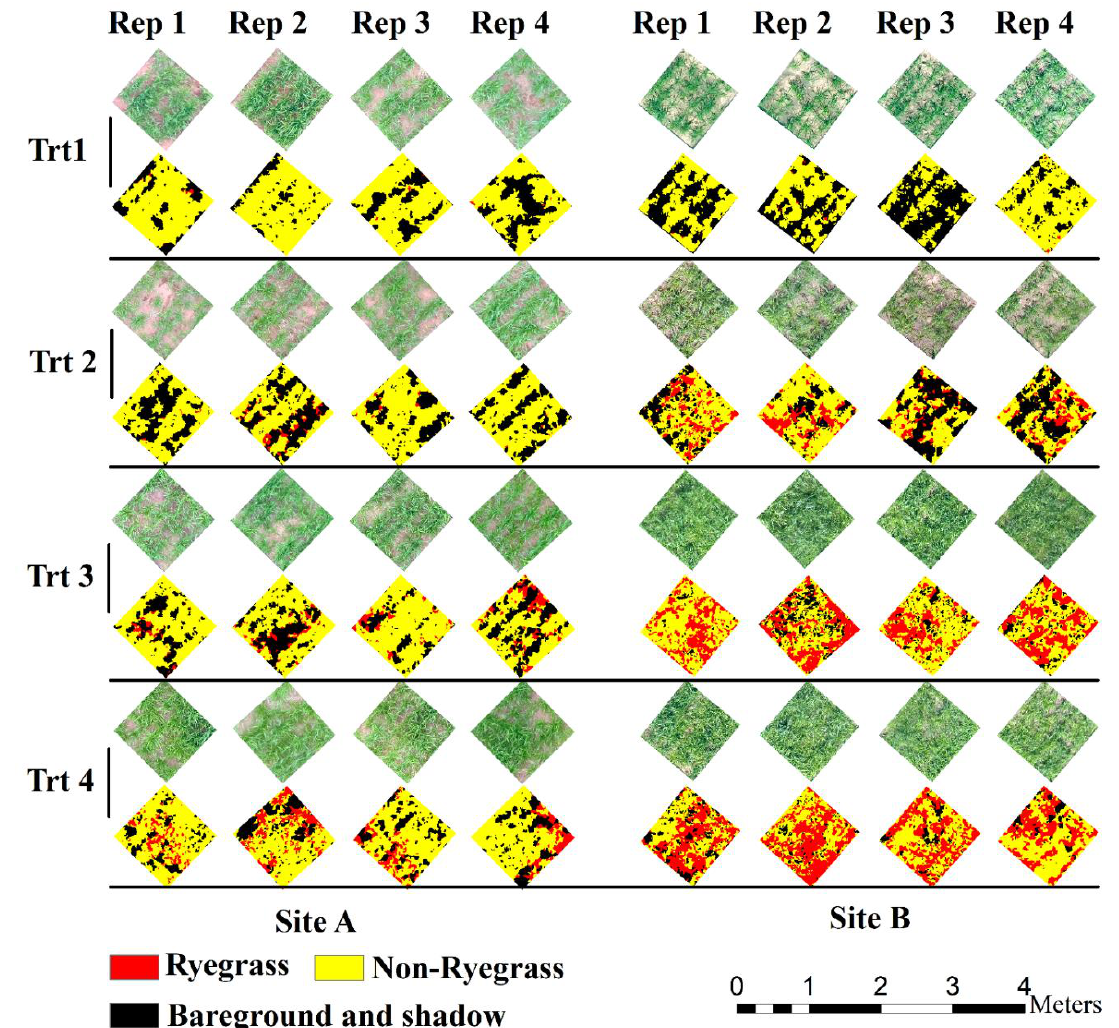
Figure 6. Implementation of the best model, that utilized color transformed features and vegetation indices, over training experimental units (1 m × 1 m quadrats) in both study sites (A and B) to detect and map Italian ryegrass in wheat. The figure consists of true color imagery and corresponding classified maps for the experimental units for weed-free check (Trt 1), low (Trt 2), moderate (Trt 3), and high (Trt 4) density treatments (red pixels: Italian ryegrass; yellow pixels: vegetation other than Italian ryegrass; and black pixels: bareground and shadow). Abbreviations: trt - treatments; rep - replications. Note: since each experimental unit was clipped based on the quadrat’s boundary visible in the imagery and because the imagery was not perfectly ortho-rectified, the size of the clipped units may range between 1 ± 0.05 m. However, this may not affect the analysis as ryegrass canopy coverage (%) was calculated based on the total size of the unit.